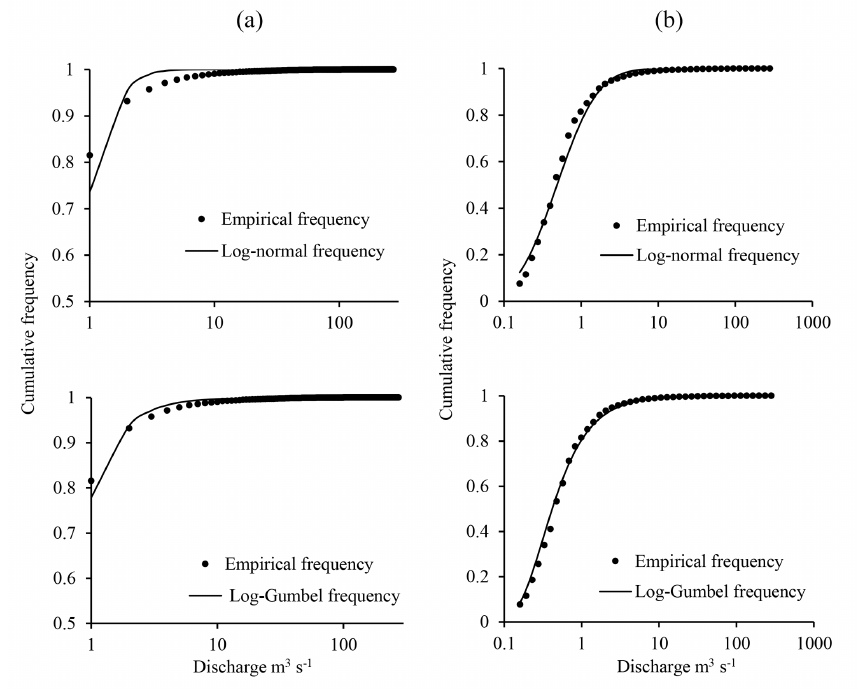
Figure 9. Adjustment of the frequency distribution of flows to the log-Gumbel probability distribution: (a) according to a subdivision into equal classes of amplitudes 1m 3 s − 1 , (b) according to a subdivision into geometric progression of common ratio 1.2.